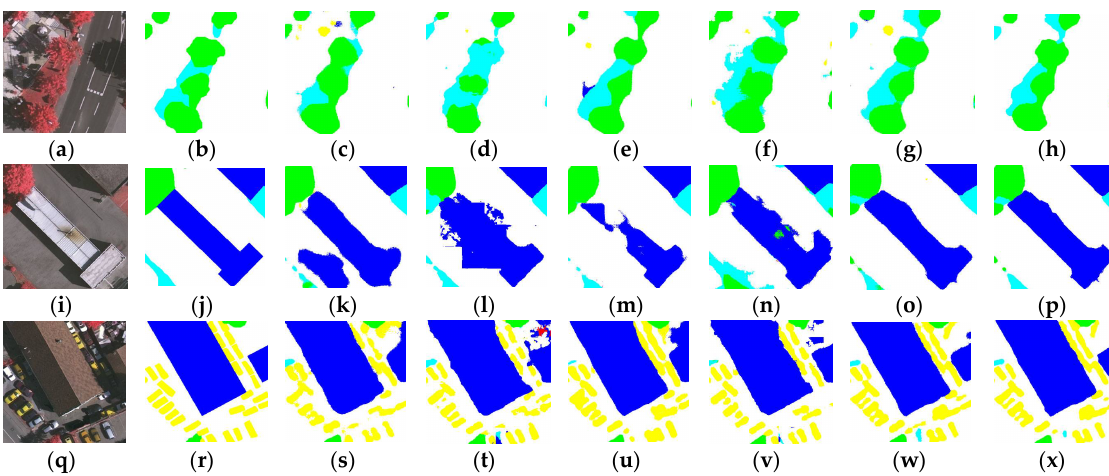
Figure 12. Semantic Labeling results for three patches of Vaihingen test set. Classes: impervious surface (white); buildings (blue); low vegetation (cyan); tree (green); car (yellow); clutter (red). In the first row, ( a ) is true orthophoto, ( b ) is ground truth, ( c - h ) are inference results of FCN-8s, SegNet, FSN-noL, HSN, FSN and FSN+CRFs for image patch with trees and low vegetation areas; in the second row, ( i ) is true orthophoto, ( j ) is ground truth, ( k - p ) are inference results of FCN-8s, SegNet, FSN-noL, HSN, FSN and FSN+CRFs for image patch with a low-rise building; in the third row, ( q ) is true orthophoto, ( r ) is ground truth, ( s - x ) are inference results of FCN-8s, SegNet, FSN-noL, HSN, FSN and FSN+CRFs for image patch with cars parked around buildings.